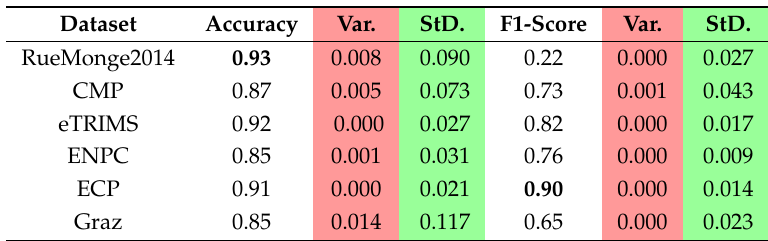
Table 4. Inference accuracy over the online datasets. Var.—Variance; StD.—Standard Deviation. The values in bold, expose the best datasets according to the Accuracy and F1-Score metrics.